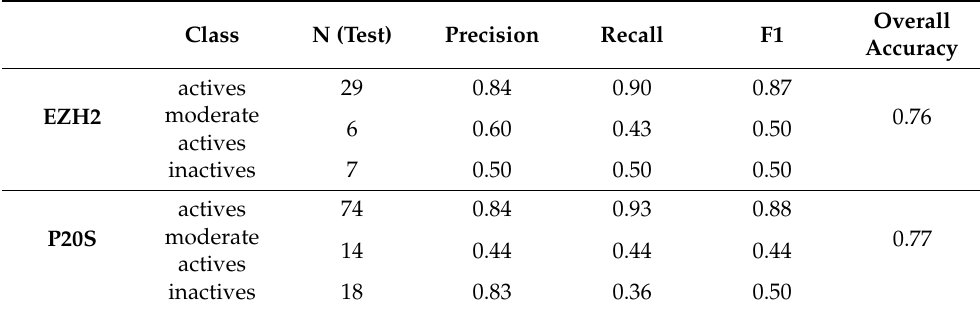
Table 2. Performance of the QSAR models built with the P20S inhibitors dataset and the EZH2 inhibitors dataset, respectively, measured on the test set. Precision Recall F1